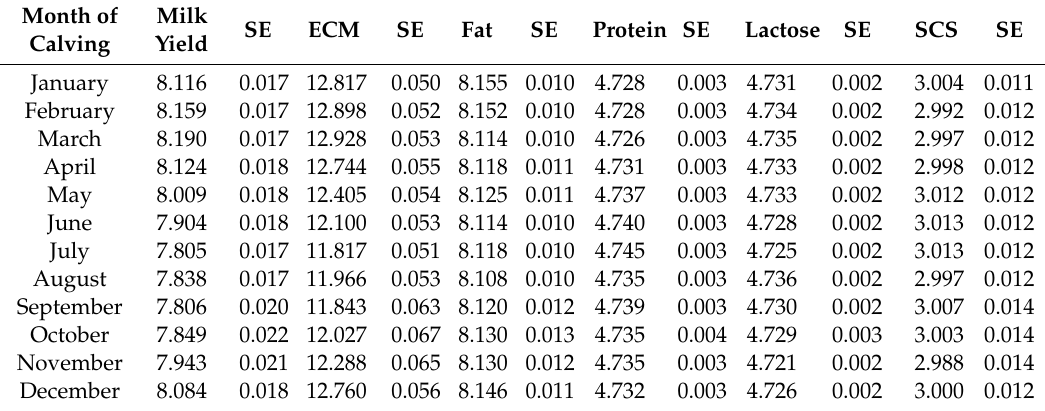
Table 3. Least square means and standard errors (SE) of milk yield (kg / d), energy corrected milk (ECM, kg / d), content (%) of fat, protein and lactose, and somatic cell score (SCS, units) for the fixed e ff ect of month of